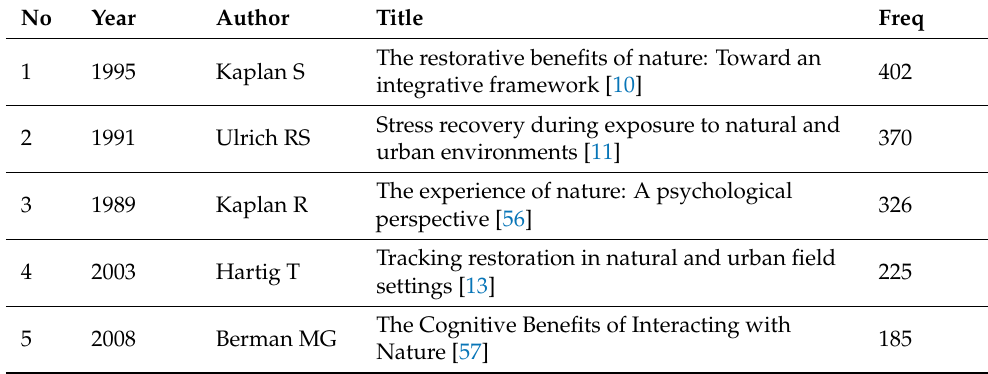
Table 1. Top 5 most cited references of network for the first step of the review, restoration